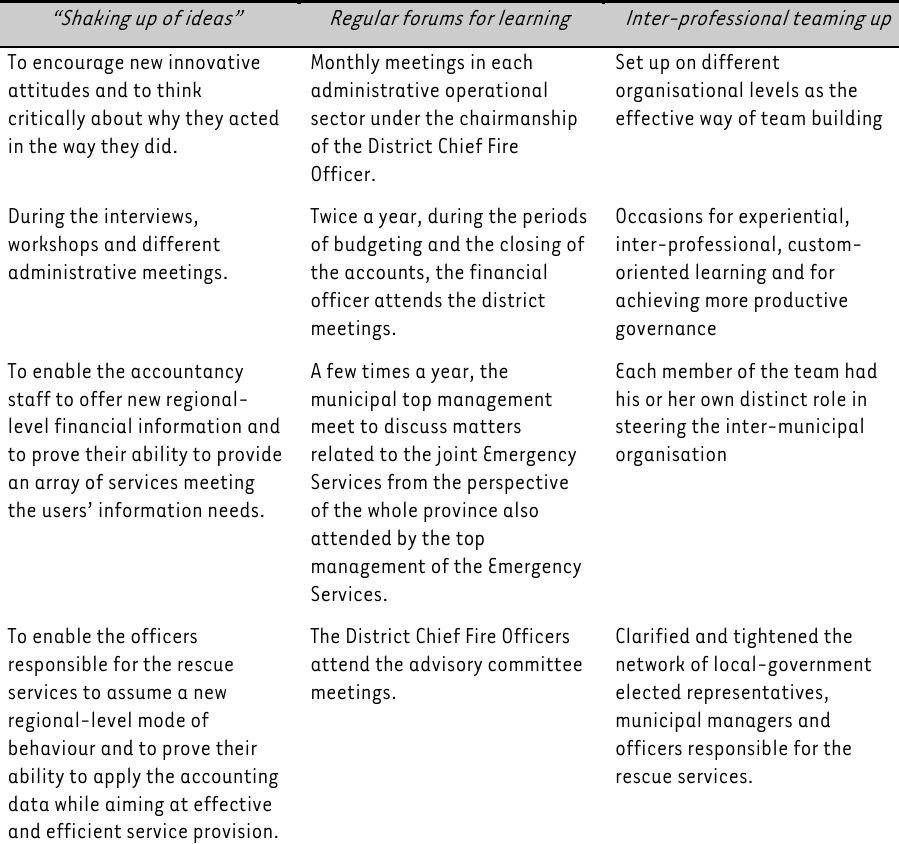
TABLE 2: The empirical interventions of the study “Shaking up of